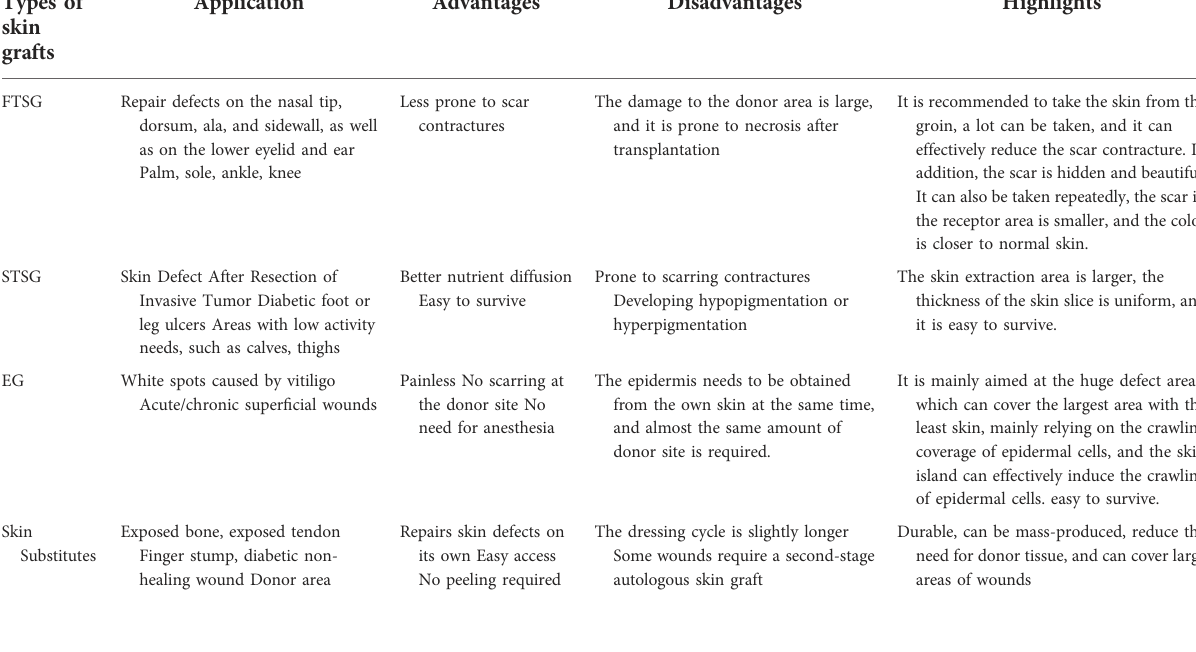
TABLE 1 Different types of skin